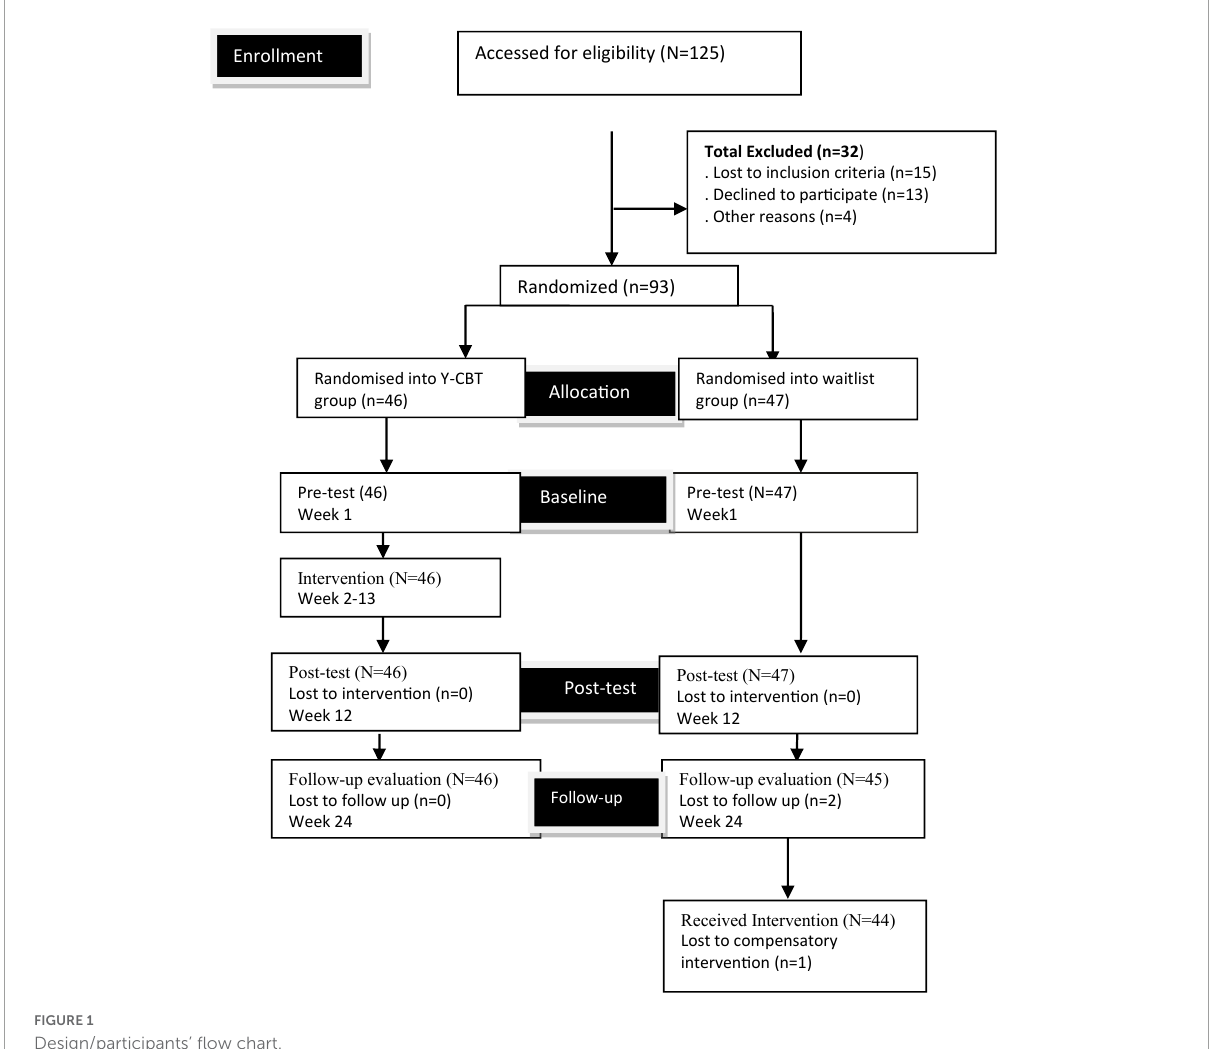
FIGURE1 Design/participants’ flow